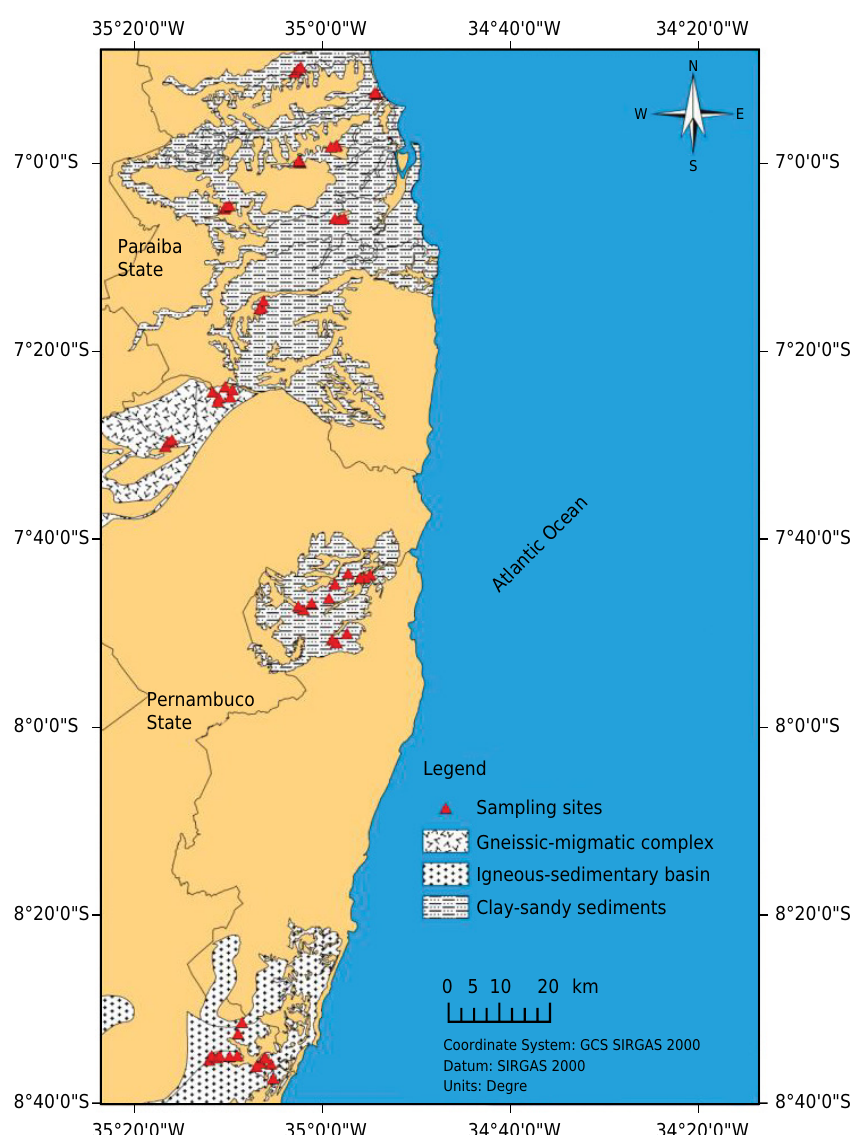
Figure 1. Sampling sites and pedogeological contexts in sugarcane growing areas in the states of Pernambuco and Paraiba, Northeastern